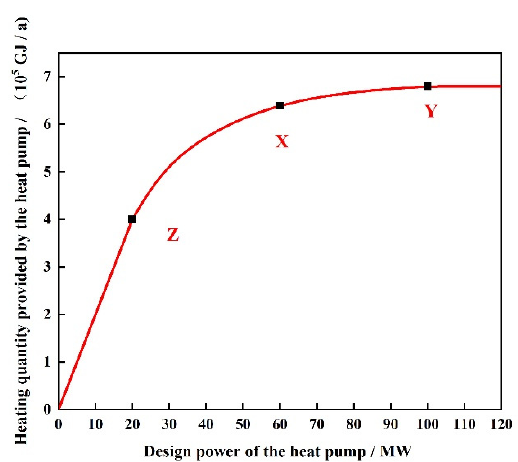
Figure 6. The supplied heating quantity of the heat pump with di ff erent design power during the heating period per year.